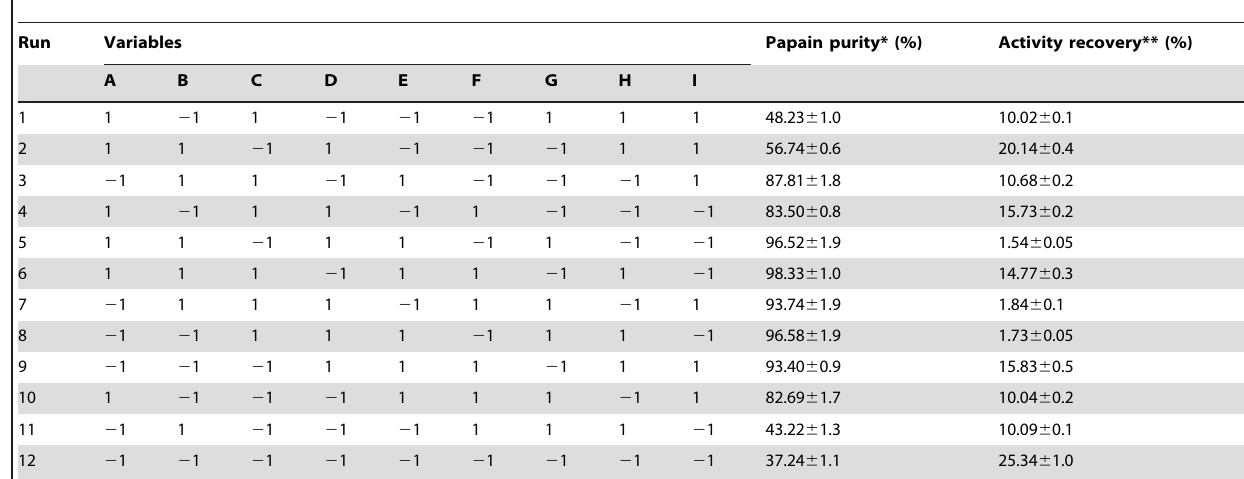
Table 1. Plackett-Burman design matrix with papain purity and activity recovery.